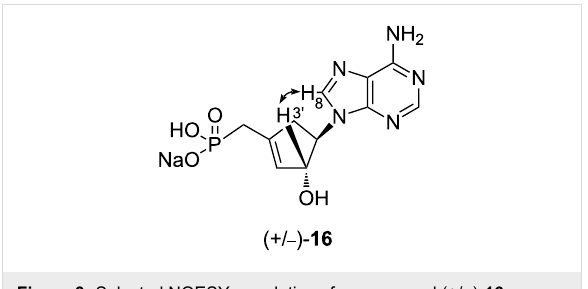
Figure 3: Selected NOESY correlations for compound (+/ − )- 16